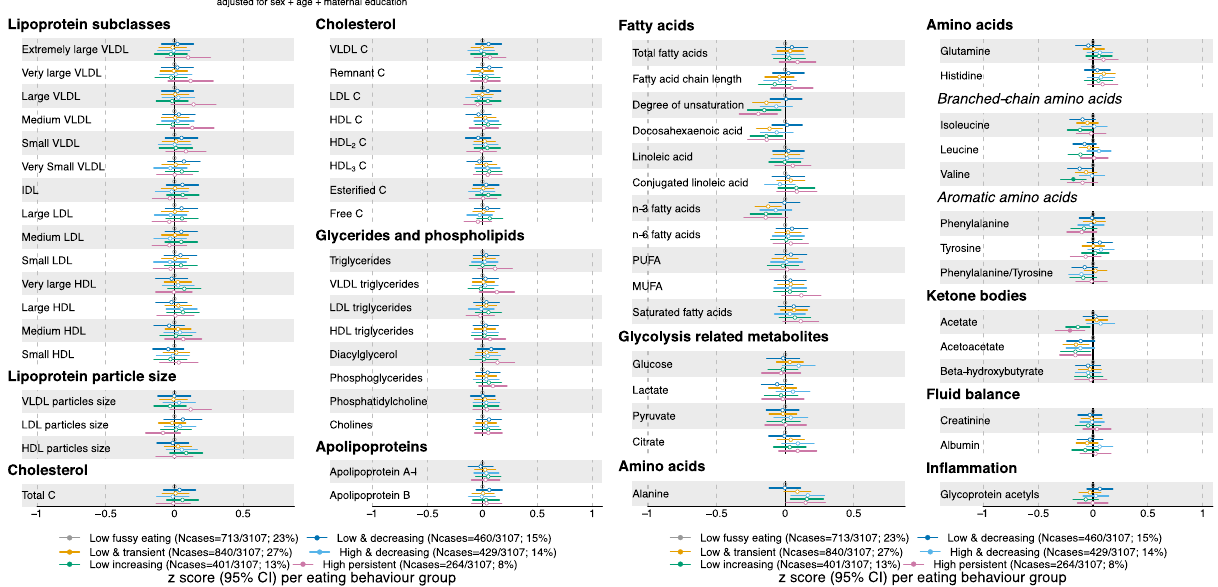
Figure 4. Estimates refer to change in standardised metabolic trait concentration at 16 years in each fussy eating trajectory, in reference to the “low fussy eating” trajectory (gray dot). Error bars = 95% confidence intervals (CI). For lipoprotein subclasses, the total lipids (= triglycerides + phospholipids + total cholesterol) point estimate (and CIs) of each 14 subclasses is presented. Estimated beta coefficients and corresponding 95% CIs for particle concentration and specific lipids in each lipoprotein subclass are given in Figure S3a–c, Supplementary Material and Table S3, Supplementary File. Analyses adjusted for sex, age at metabolite measure and maternal education. Note Association where CIs do not cross 0, p-value < 0.05; Filled dot: Association meets the p-value threshold of < 0.003. C cholesterol, IDL intermediate-density lipoprotein, LDL low-density lipoprotein, HDL high-density lipoprotein, VLDL very low-density lipoprotein, MUFA monounsaturated fatty acids, PUFA polyunsaturated fatty acids. Note Filled dot: CI do not include the null. MUFA, PUFA and saturated fatty acid concentrations include all fatty acids detected which have one, more than one, or zero C=C double bonds in their backbone, respectively.